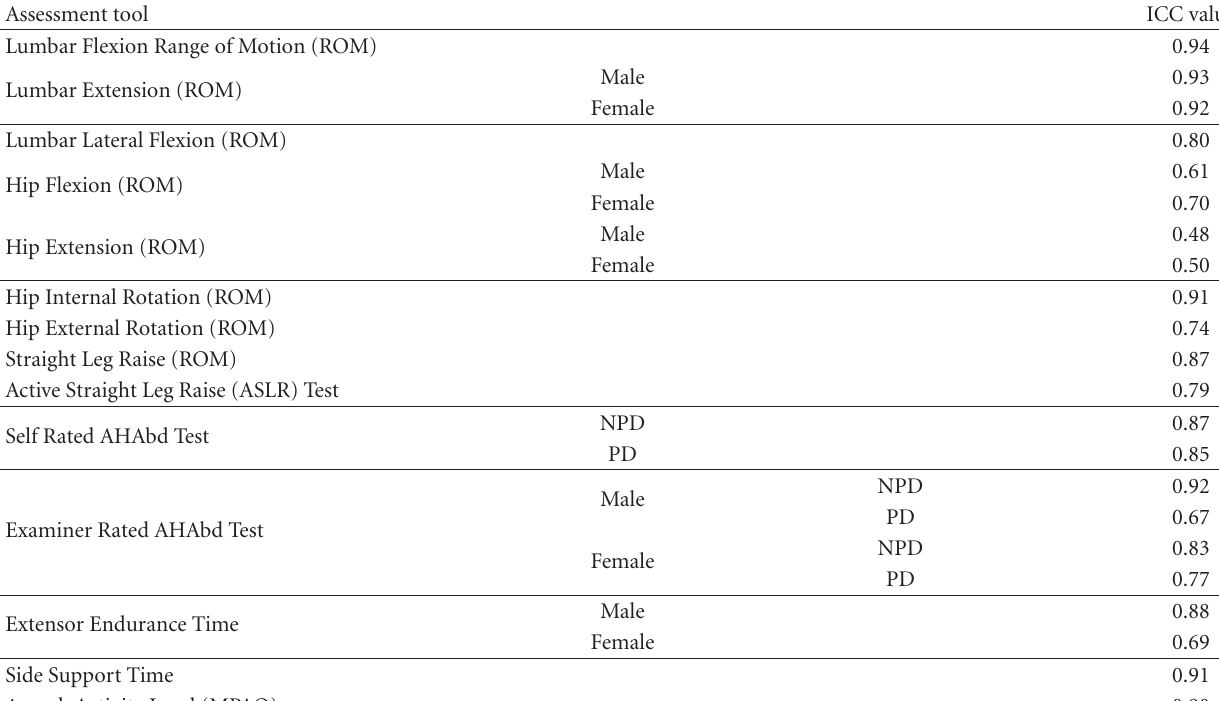
Table 4: Between-day repeatability for clinical assessment